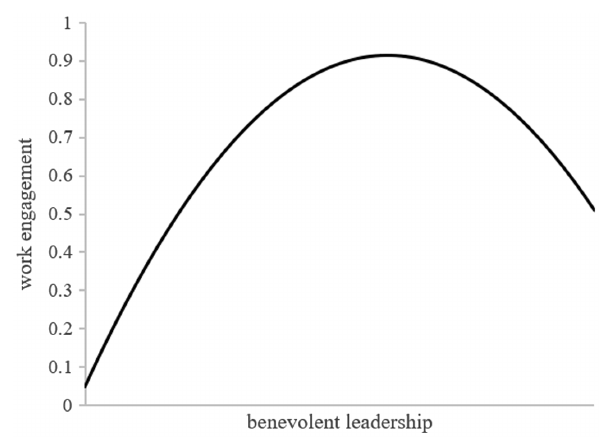
TABLE 6 | Unconflated multilevel model, group level.